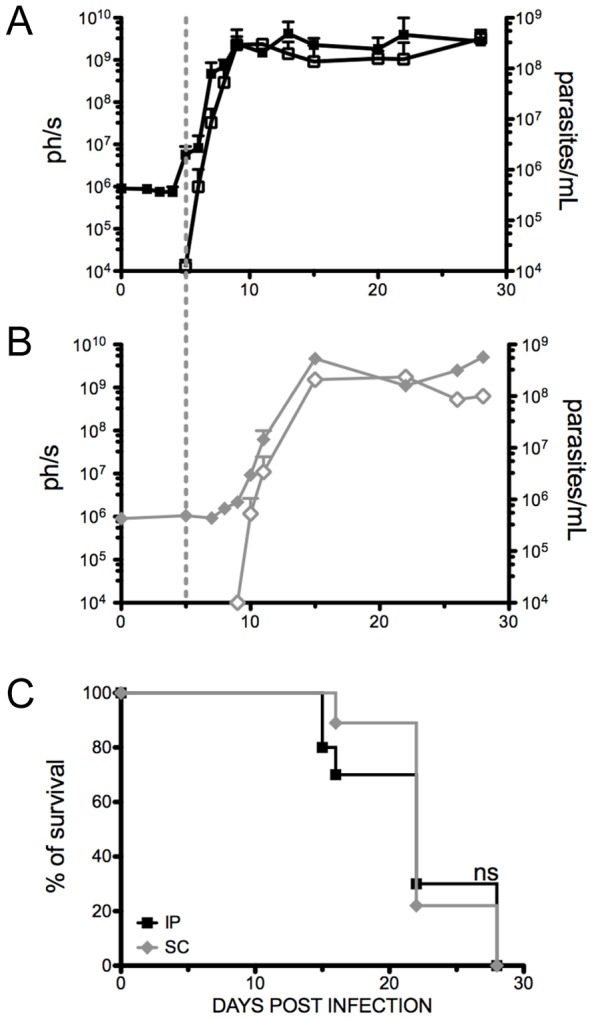
Mice injected by the subcutaneous route show a longer prepatent period than those injected intraperitoneally.Parasitemia (empty symbols) and total bioluminescence (full symbols) were determined in groups of mice injected with 102
TvLrDNA-luc parasites by (A) the intraperitoneal route (squares) or (B) the subcutaneous route (diamonds). The graphs depict the arithmetic means of values obtained individually for at least 3–6 mice per time point ± SD of the means. The results are representative of two independent experiments that used respectively 16 and 18 mice for the intraperitoneal route and 12 and 14 mice for the subcutaneous route. For a better comparison, the dashed vertical line that crosses the figures A and B illustrates the onset of microscopically-detectable parasitemia (104/ml blood) for the IP injected group. C. Survival rates for the different infection routes. The cumulative mortality was recorded over time and survival curves are the result from the combination of the two independent experiments and Kaplan-Meir survival estimate curves were plotted. Only 3–6 mice (20–30%) are alive by the end of each of the two experiments but all die at day 28 of infection. Comparison between the curves was performed using the non parametric Mantel-Cox log-rank test. No significant difference was observed between the plots; p>0.5.